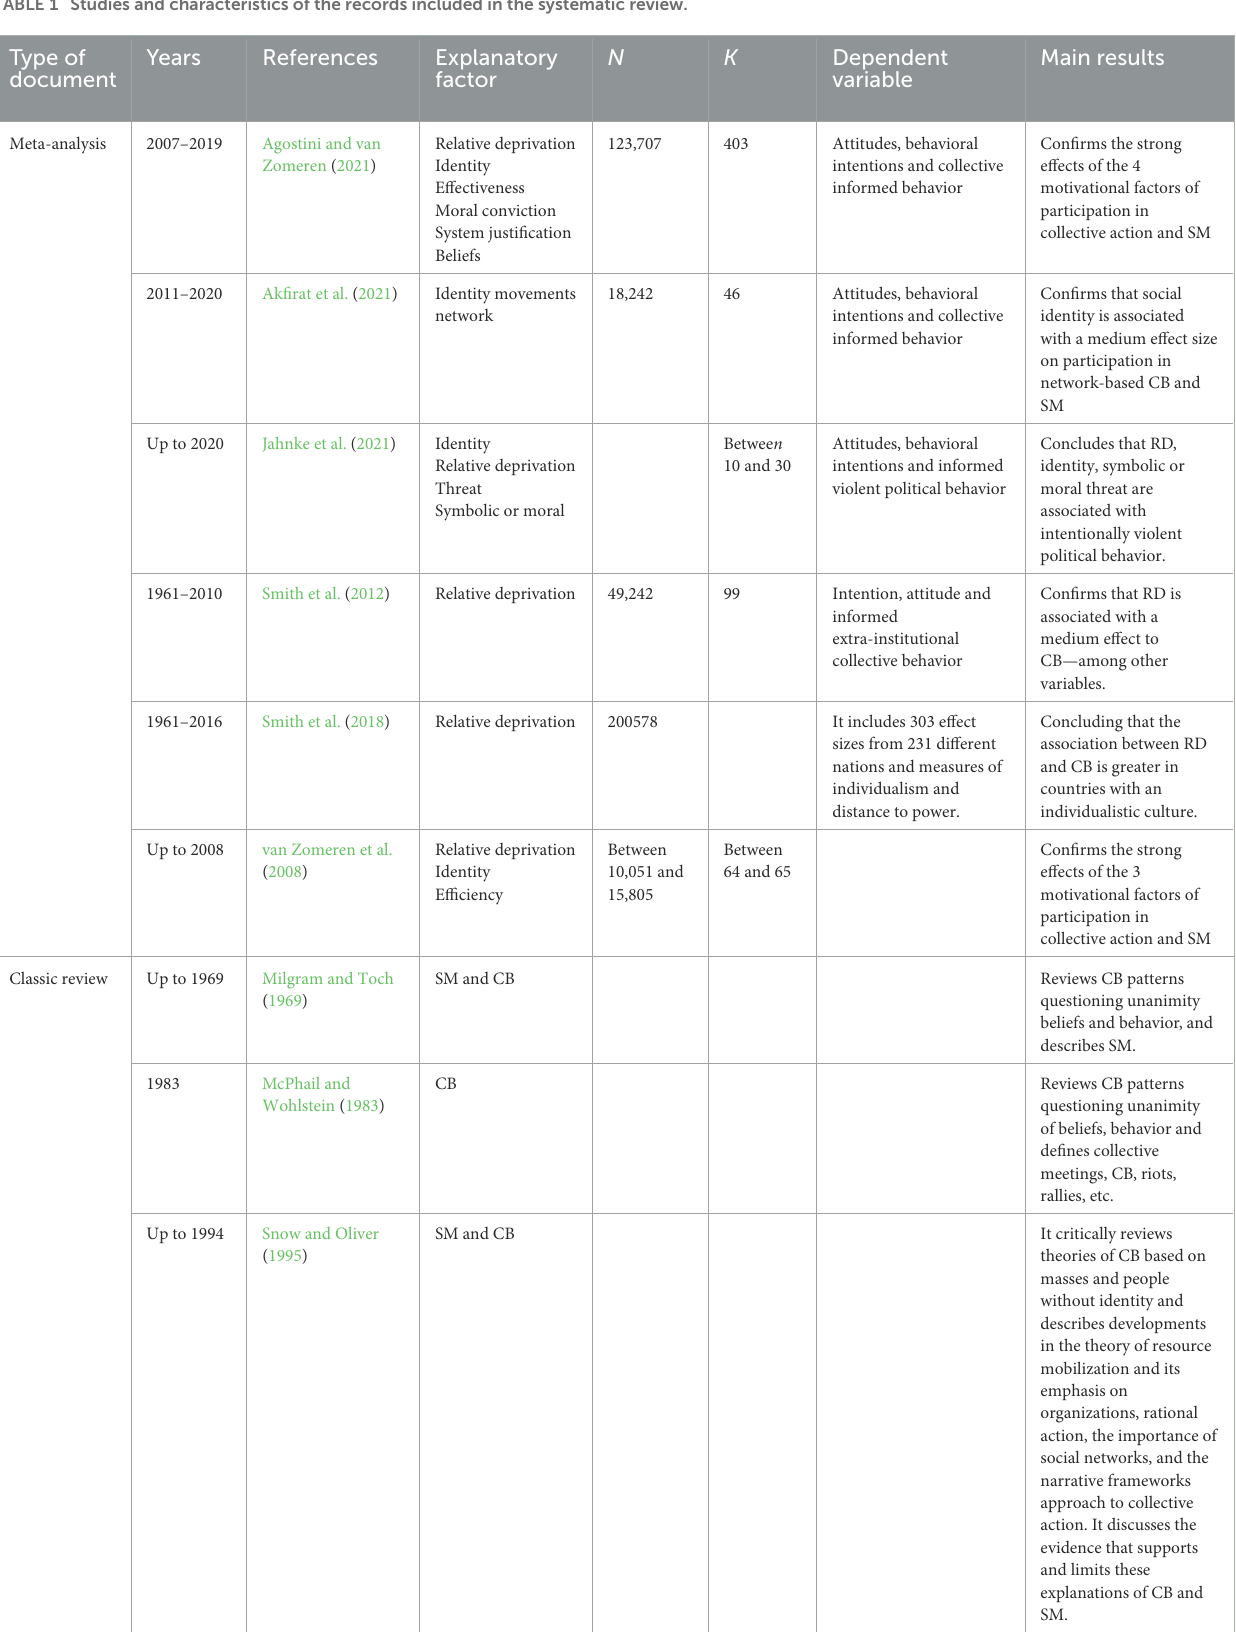
TABLE 1 Studies and characteristics of the records included in the systematic